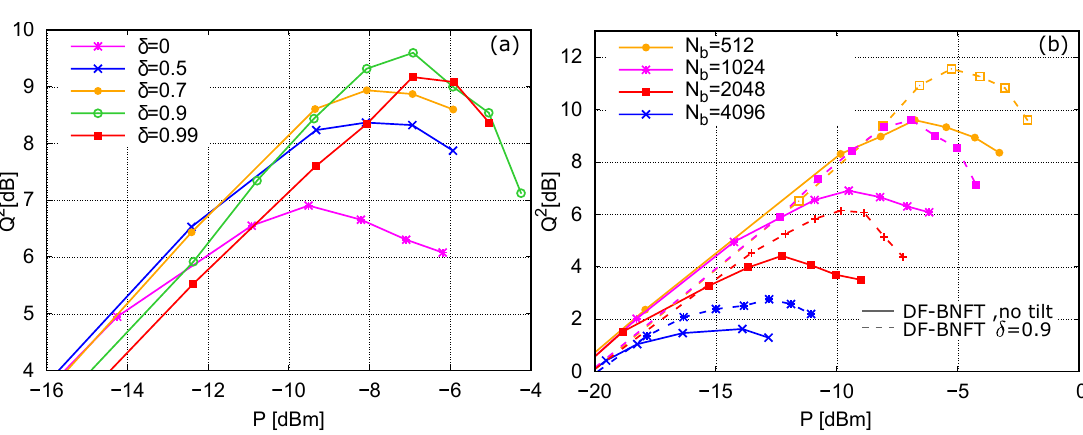
Figure 7. ( a )Performance of NFDM systems with DF-BNFT detection and NIS modulation, for N b = 1024 and different tilt strength δ , ( b ) Performance of NFDM systems with DF-BNFT detection and NIS modulation without power tilt (solid lines) and with 0.9 tilt (dashed